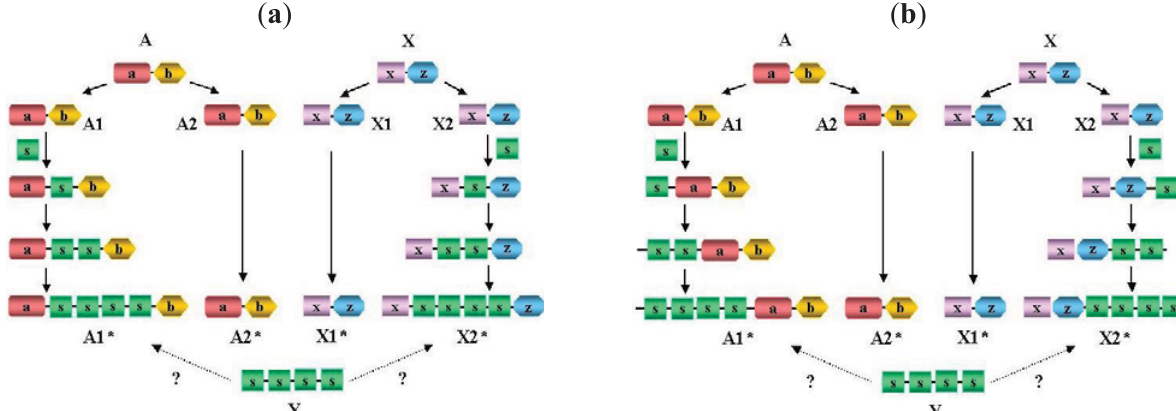
Figure 3. Domain Architecture evolution: consequences of confusing epaktology and paralogy. Proteins A and X are unrelated ancestral multidomain proteins. During evolution domain shuffling inserts the same domain-type (domain s) into orthologs of A and X proteins independently followed by tandem duplication of this domain, resulting in proteins A1* and X2* in an extant species (Species*). Overall sequence similarity score of proteins A1* and X2* may be so significant that A1* appears to be much more closely related to X2* than its true paralog (A2*), therefore, based on sequence similarity searches it may be concluded that X2* is the closest paralog of A1* (inferring. that A1* and X2* diverged from a common hypothetical ancestor Y) and that independent terminal gain of domains a,b and x,z occurred in the two lines leading to paralogs A1* and X2*. In contrast with this interpretation, A1* is a paralog of A2* (and X1* is a paralog of X2*) and independent gain and duplication of an s domain occurred in both lineages. Note the that although the two scenarios depicted in (a) and (b) differ in the actual events (internal vs. terminal insertion of domain s), if the epaktologs are treated as paralogs the conclusion will be similar in as much as the DA of A1* and X2* differ in terminal